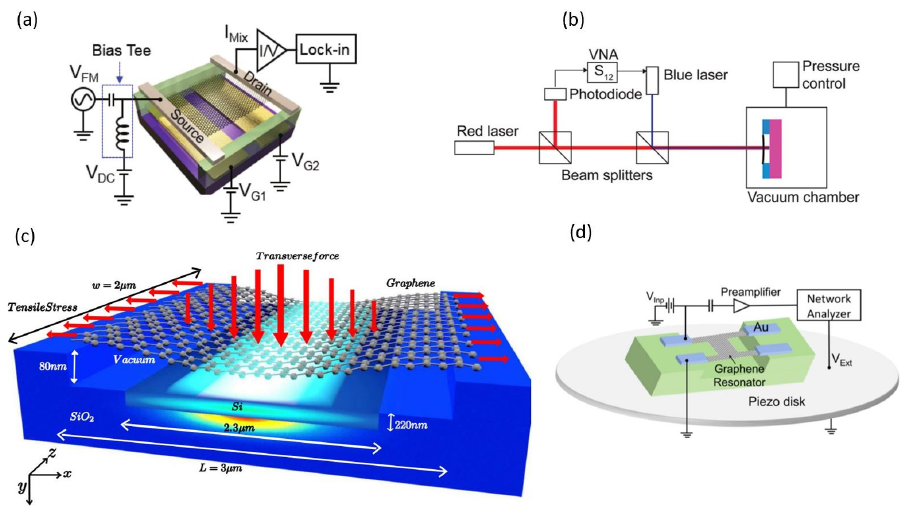
Figure 3. Excitation schemes for graphene resonators. ( a ) Electrostatic excitation scheme with a bipolar region [32]. ( b ) Optic excitation scheme with intensity-modulated laser [34]. ( c ) Excitation scheme with optical gradient forces [36]. ( d ) Piezoelectric excitation scheme by placing graphene on